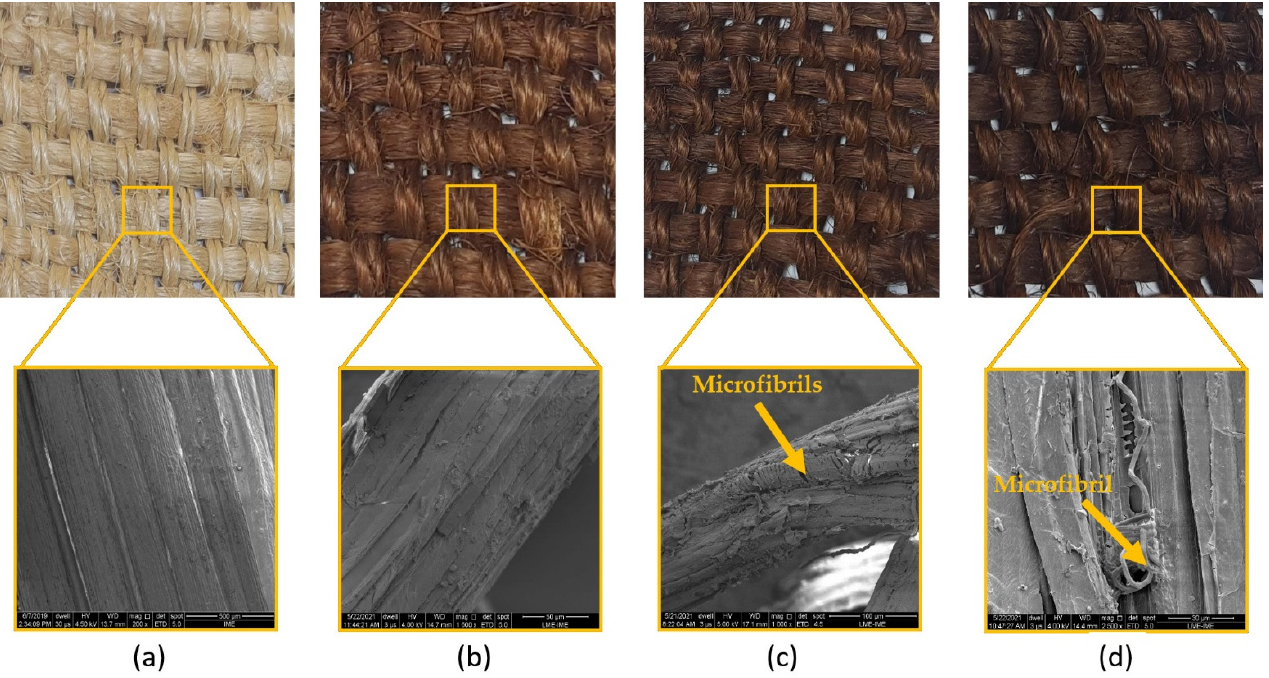
Figure 3. Visual changes and SEM micrographs of fique fiber after high temperature aging: ( a ) 0 h; ( b ) 72 h; ( c ) 120 h; ( d ) 240 h at high temperature (170 °C).